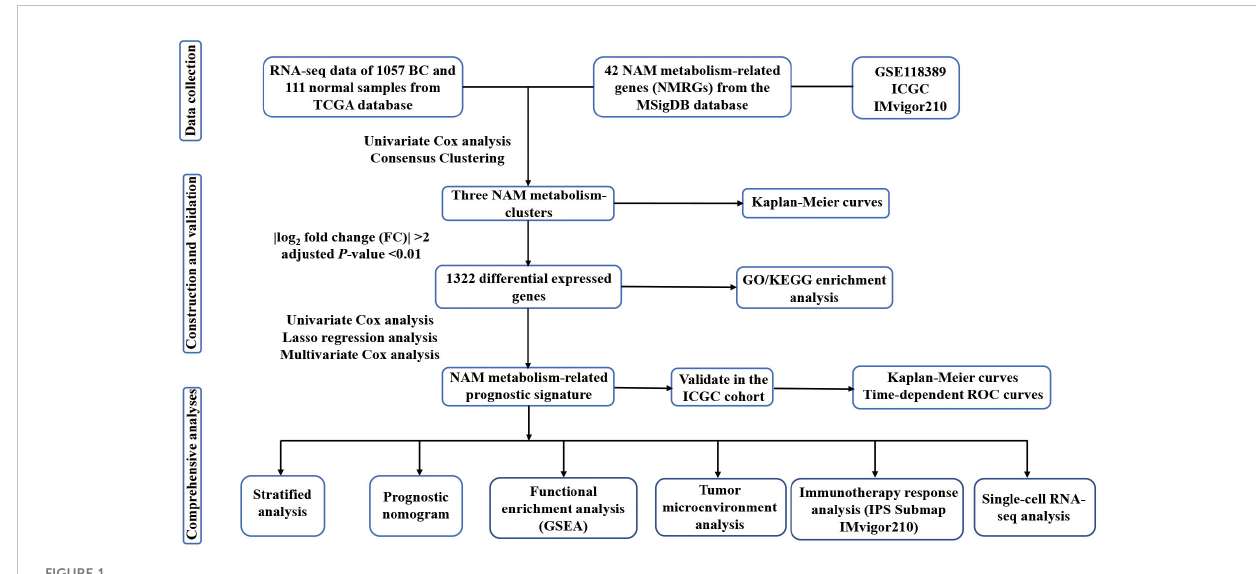
FIGURE 1 The fl ow chart of the